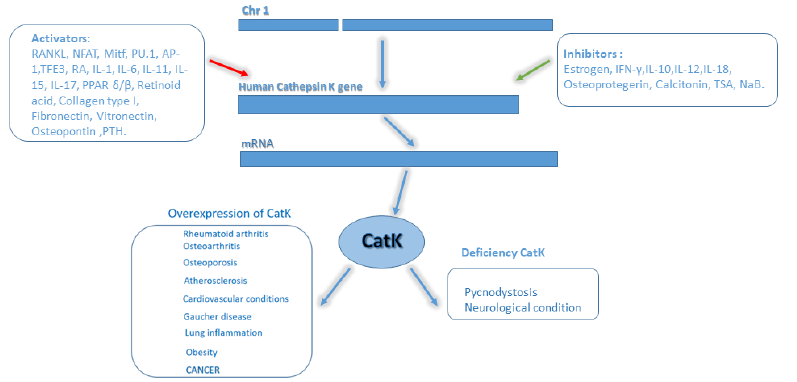
Figure 1. Localization and regulation of CatK gene and involvement in pathological conditions. Human CatK is encoded by a single-copy gene of approximately 12.1 kb on chromosome 1q21, with 8 exons and 7 introns. CatK is 329 amino acids long, comprising signal peptide 15 N-terminal amino acids, 99 forming the pro-peptide, and 215 amino acids forming the catalytic unit. CatK expression is regulated by multiple proteins in positive and negative manners. Overexpression of CatK causes picnodystosis and several neurological conditions.